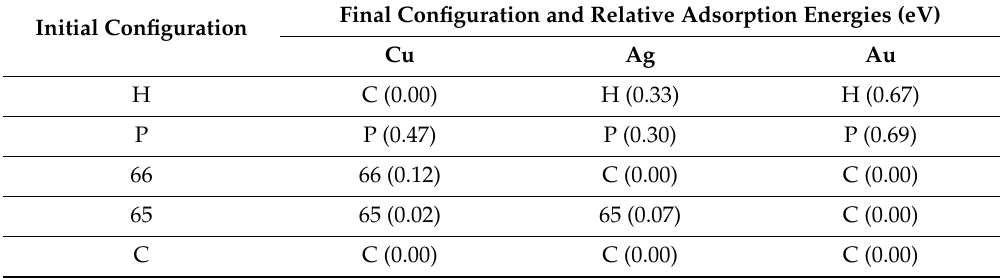
Table 3. Initial and final configurations of coinage metal atoms adsorbed by the outer surface of the C 60